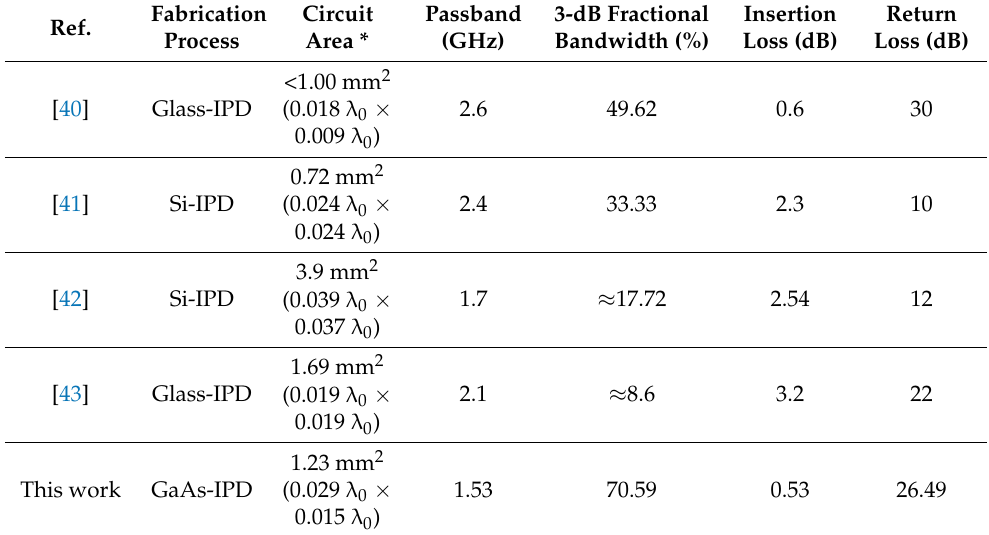
Table 4. Performance comparison of the proposed BPF and published BPFs.